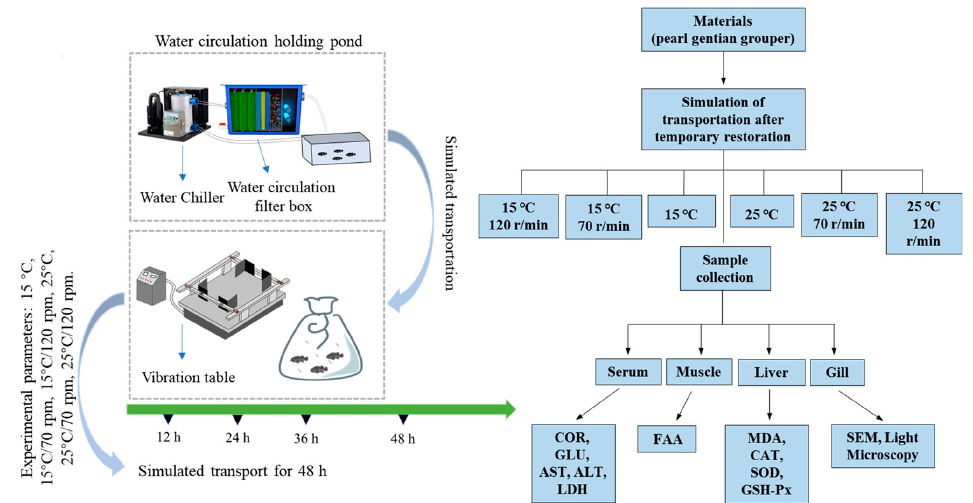
Figure 1. Schematic diagram of simulated transport of pearl gentian groupers. The groupers were temporarily raised for 24 h through a chiller and a circulating water tank. The fish were placed in a plastic bag for oxygenation and placed on a vibration table to simulate transportation for 48 h.